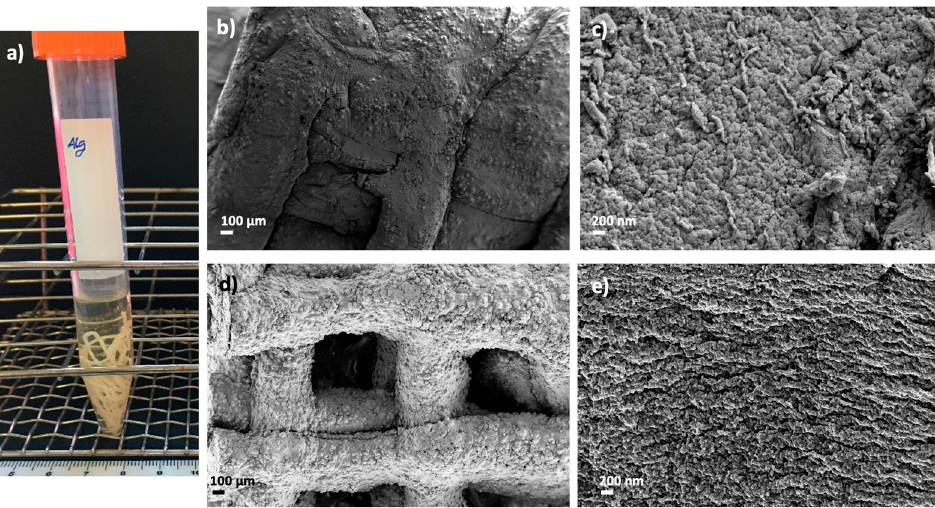
Figure 9. Supercritical sterilization of 3D-printed alginate aerogels: ( a ) Images of sterile and dual crosslinked aerogel scaffolds seeded on TSB tubes after 24 h of culture. Optical and SEM images of sterile (st) and aged aerogel scaffolds: ( b , c ) Alg 6%, HA 8%, CaCl 2 1M1h, st and ( d , e ) Alg 6%, HA 8%, CaCl 2 1M1h, GA, st. Aerogels were observed at two different